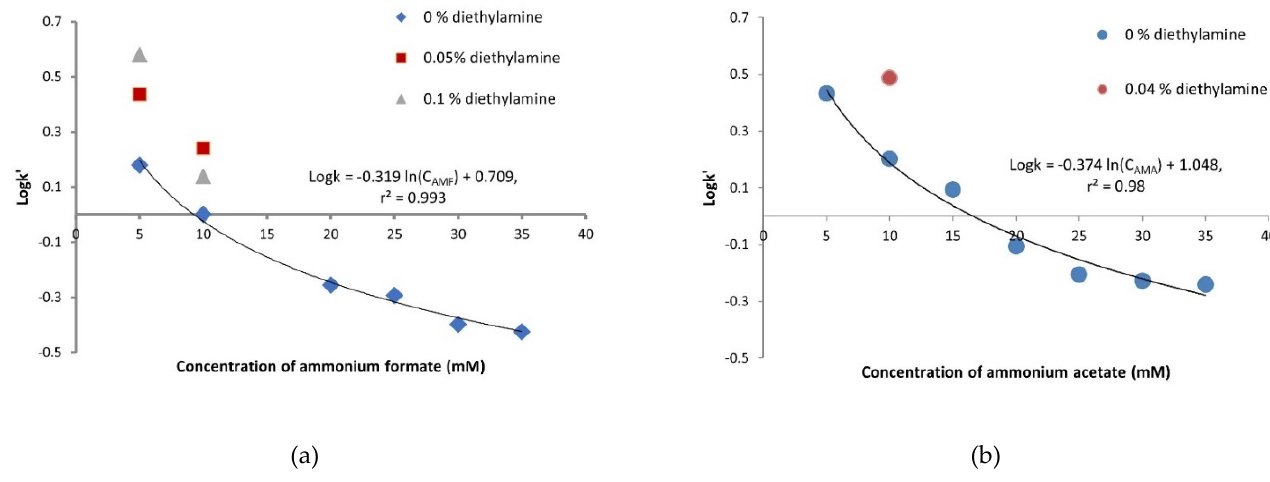
Figure 2. Plots of the logarithm of capacity factor (Logk) of octreotide versus the concentration of ( a ) ammonium formate (C AMF ) and ( b ) ammonium acetate (C AMA ), in the aqueous component of the mobile phase that consisted of acetonitrile/ aqueous buffer 70/30 v/v .